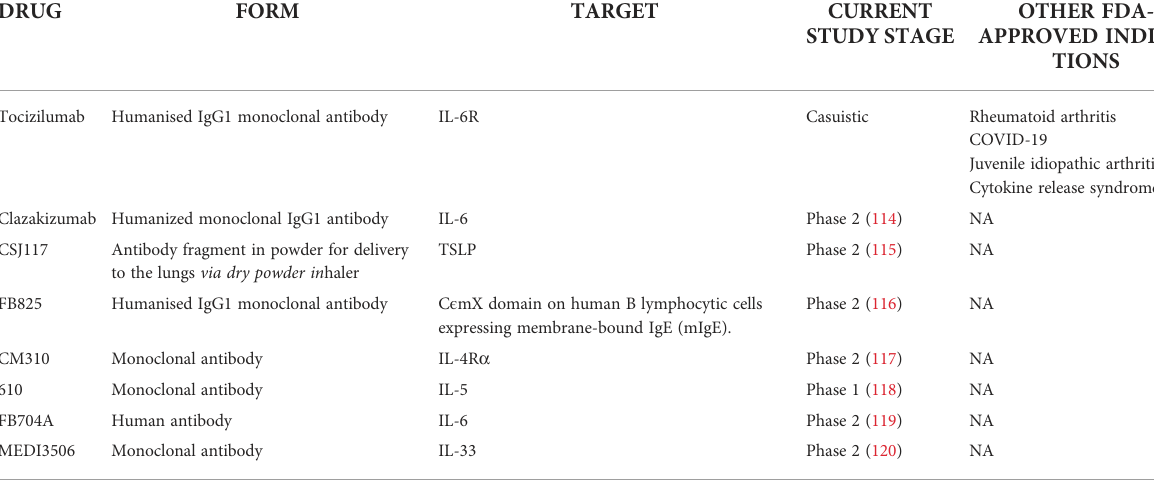
TABLE 3 Monoclonal antibodies and drugs in current clinical trials or suggested as potential agents in severe asthma.